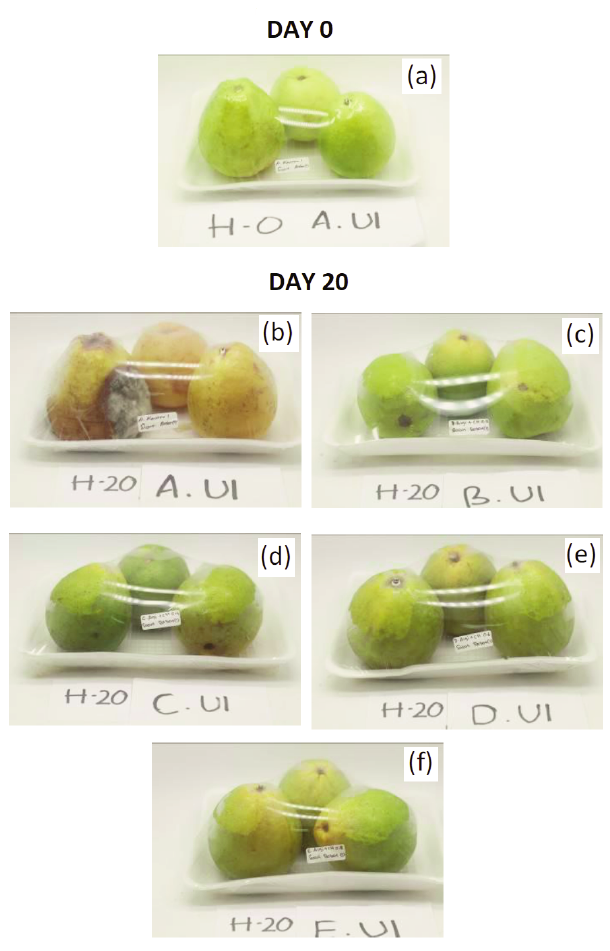
Fig. 1 ­ Visual appearance of guava fruit on day 0 (a) and after 20 days of storage with: no edible coating (b); 0.2% alginate + 0.2% Cyclea barabata leaves powder (CBLP) (c); 0.2% alginate + 0.4% CBLP (d); 0.2% alginate + 0.6% CBLP (e); 0.2% alginate + 0.8% CBLP